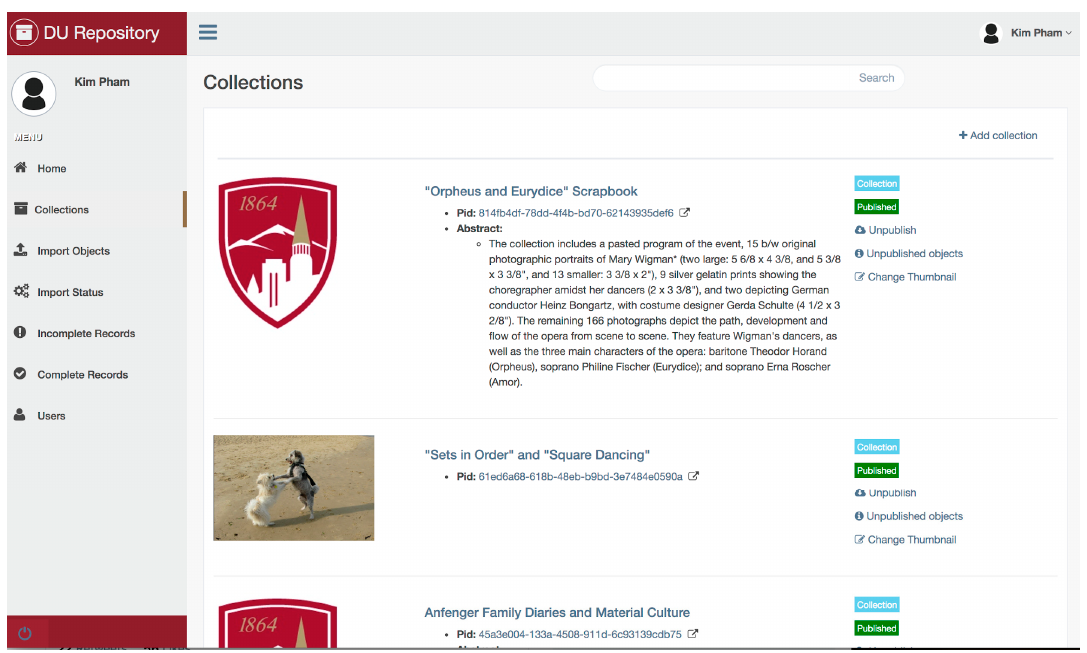
Figure A7. Repository module.